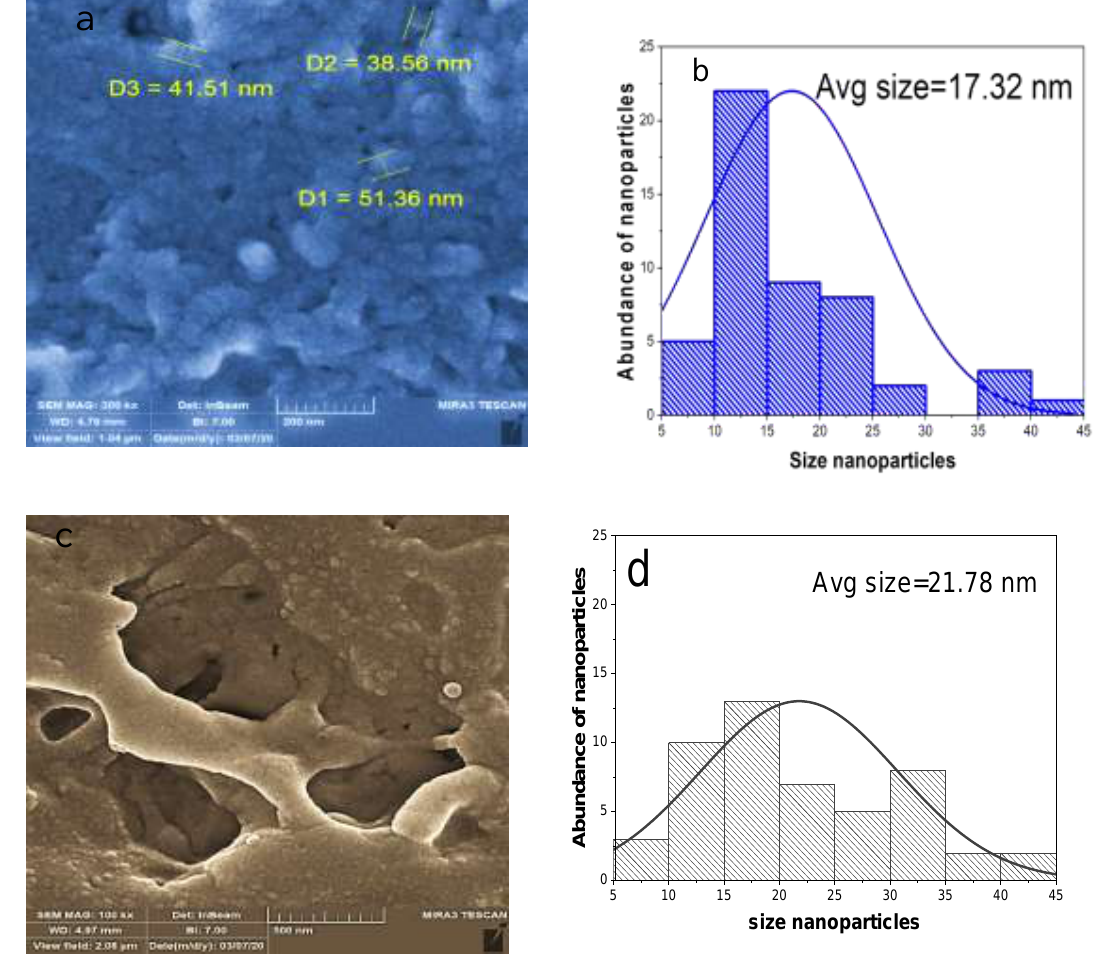
Fig. 2 : CNPs synthesized with optimum pulses laser in ethanol (a) FESEM image of the synthesized sample at (1000)Pulse / sec (b) Distribution of the scale of CNPs relating to (a), (c) FESEM image of the optimum sample at (500)Pulse/sec (d) Distribution of the scale of CNPs relating to